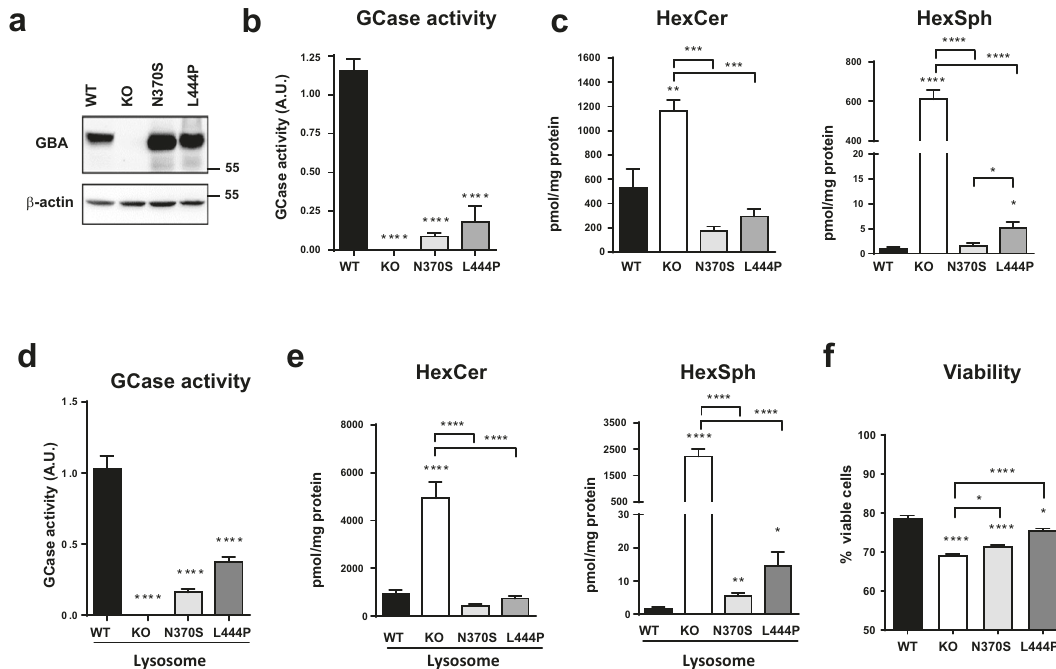
Fig. 1 Loss of lysosomal GCase activity leads to substrate accumulation in GBA mutant cells. a Immunodetection of GBA protein; b GCase activity in total homogenate corrected by levels GBA protein, n = 3 in each group. c Quanti fi cation of total HexCer (left) and total HexSph (right) by LC/MS-MS, n = 3 in each group. d Lysosomal GCase activity in isolated lysosomal fractions, n = 4 independent isolations in each group. e Quanti fi cation of HexCer (left) and HexSph (right) by LC/MS-MS, n = 3 – 4 in each group. f Cellular viability, n = 6 independent samples. In all panels, data is presented as mean ± s.e.m. Statistical signi fi cance was established at * p < 0.05, ** p < 0.01, *** p < 0.001, **** p < 0.0001 compared to WT samples or between mutant lines when indicated after one-way ANOVA followed by Tukey ’ s multiple comparisons (Fig. 1d) by analyzing pure lysosomal fractions isolated from all cell lines and validated using lysosomal markers (Supplementary Fig. S1b). The effect on sphingolipid accumulation was intensi- fi ed in the lysosomal compartment, the enrichment of sphingo- lipids was higher in this subcellular fraction and more signi fi cant increase in the levels of HexSph substrate was observed in all mutant differentiated cell lines (Fig. 1e). The decrease in GCase activity and increase in substrate accumulation is associated with a decrease in the cellular viability of all three mutant cell lines (Fig. 1f).